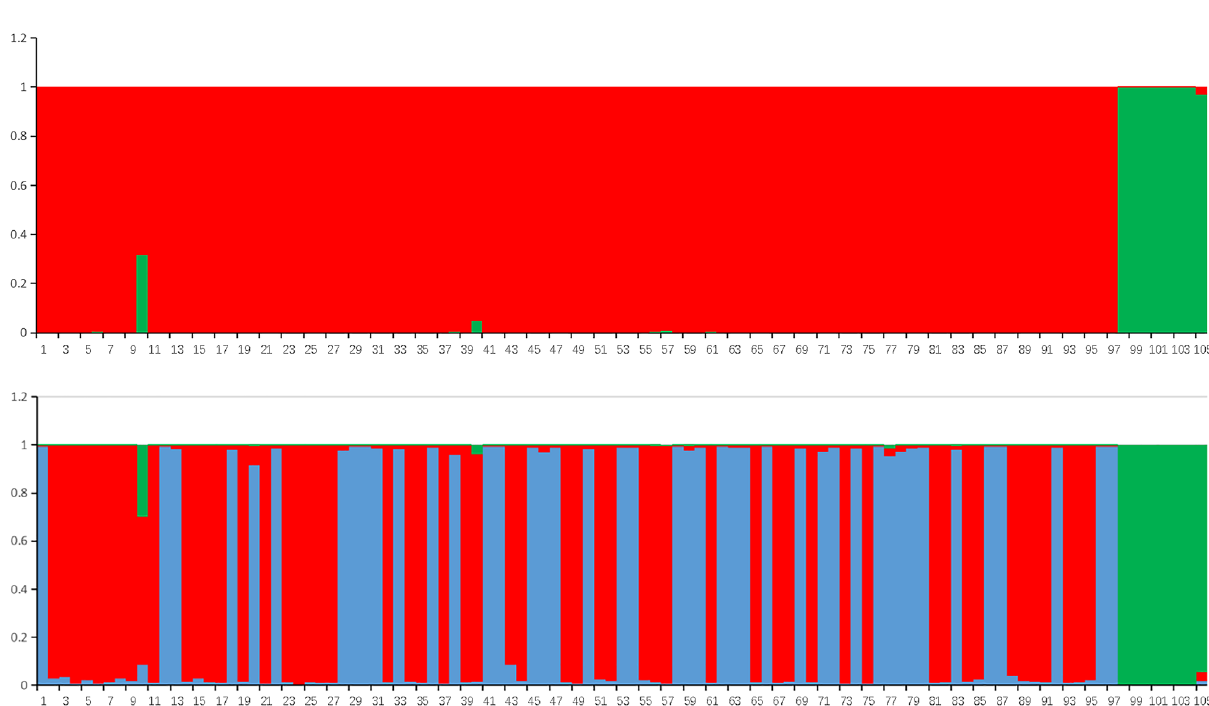
Figure 2. Genetic relationships among the 105 accessions of sweet potato revealed by a Bayesian modeling approach under K = 2 (top) and K = 3 (bottom) (numbers 1 to 105 represent the 105 sweet potato